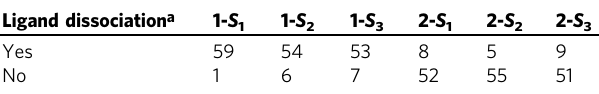
Table 1 Observed ligand dissociation in well-tempered metadynamics